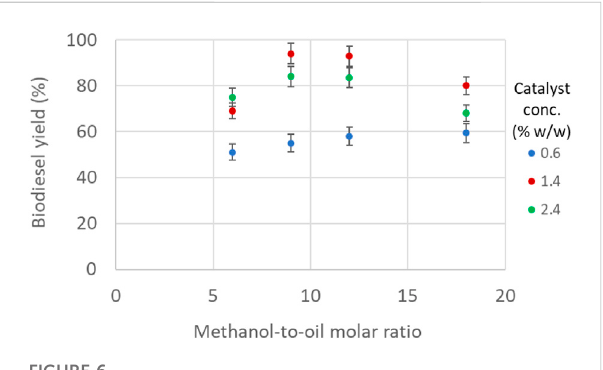
FIGURE 5 Interfacial area-to-volume ratio as a function of methanol-to-oil fl ow rate ratio during plug fl ow (Q